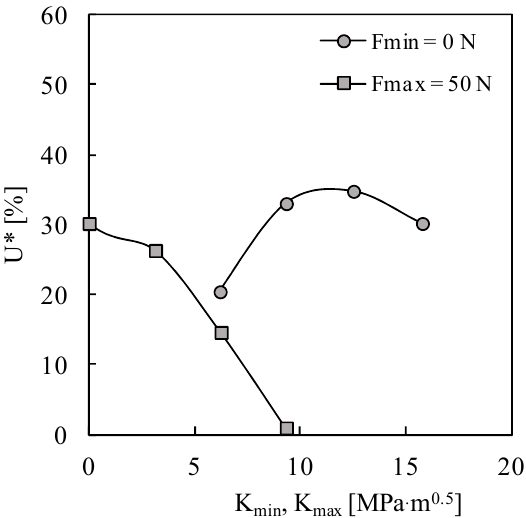
Figure 5. Variation of crack opening parameter with maximum and minimum loads.